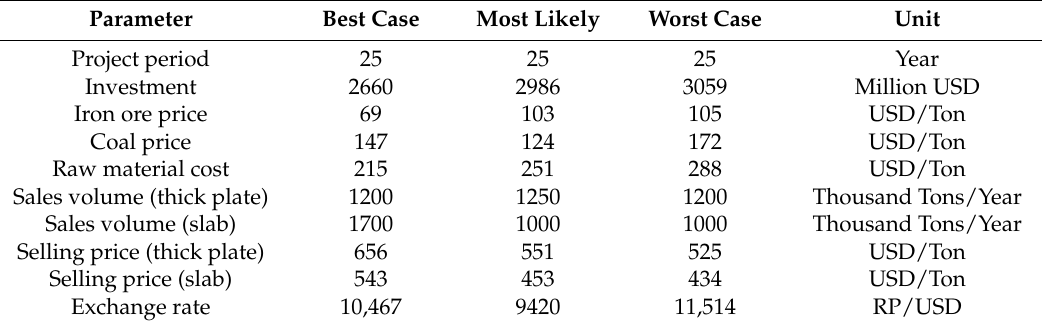
Table 5. Economic data for virtual Project